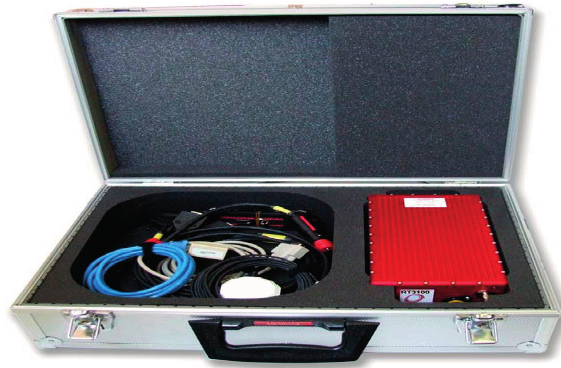
Figure 1. RT3102 navigation